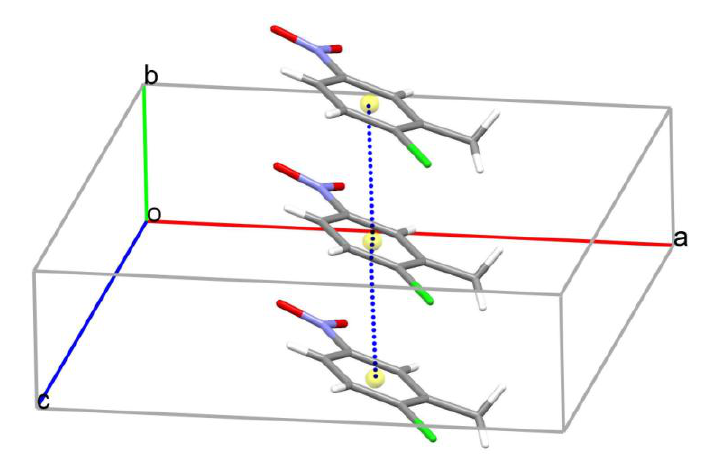
Figure 3. π…π stacking interactions [17] between adjacent aromatic rings in 3